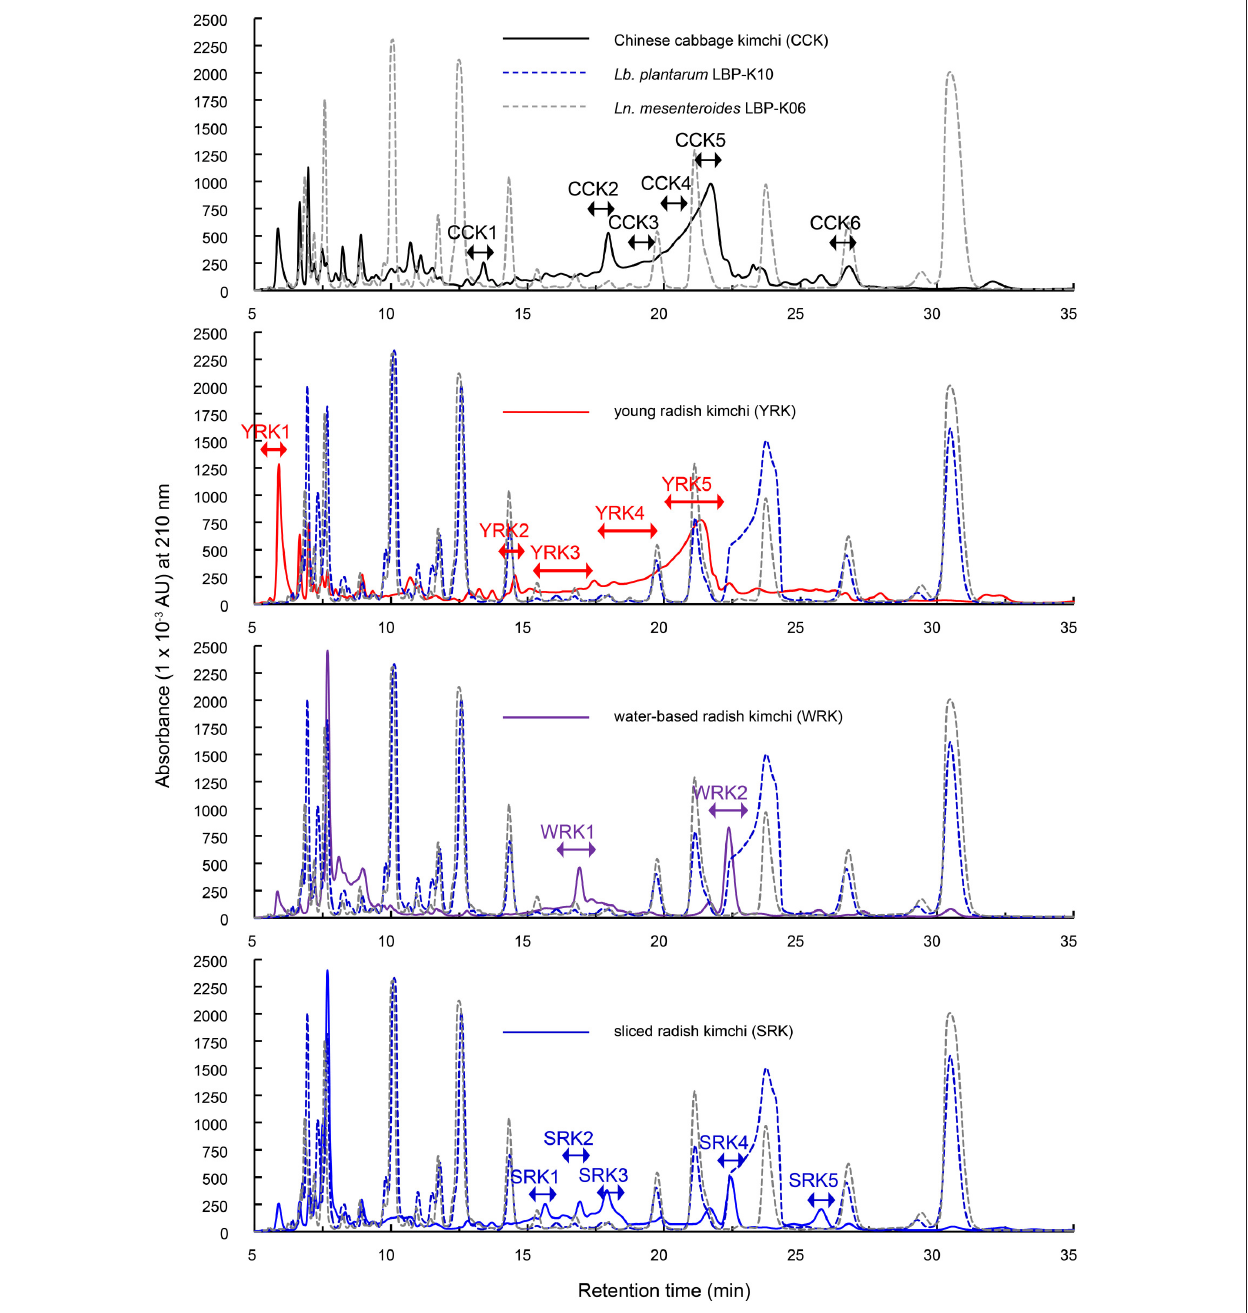
FIGURE 3 | Overall HPLC fractionated pattern of fermented kimchi products of plant origin using their whole filtrates as described in the materials and methods section. The culture filtrates in the Lb. plantarum LBP-K10 and Ln. mesenteroides LBP-K06 were used as reference experiments, as indicated. A chromatographic analysis of all filtrates derived from LAB strains was performed at a wavelength of 210 nm. All experimental trials were repeated at least three times.